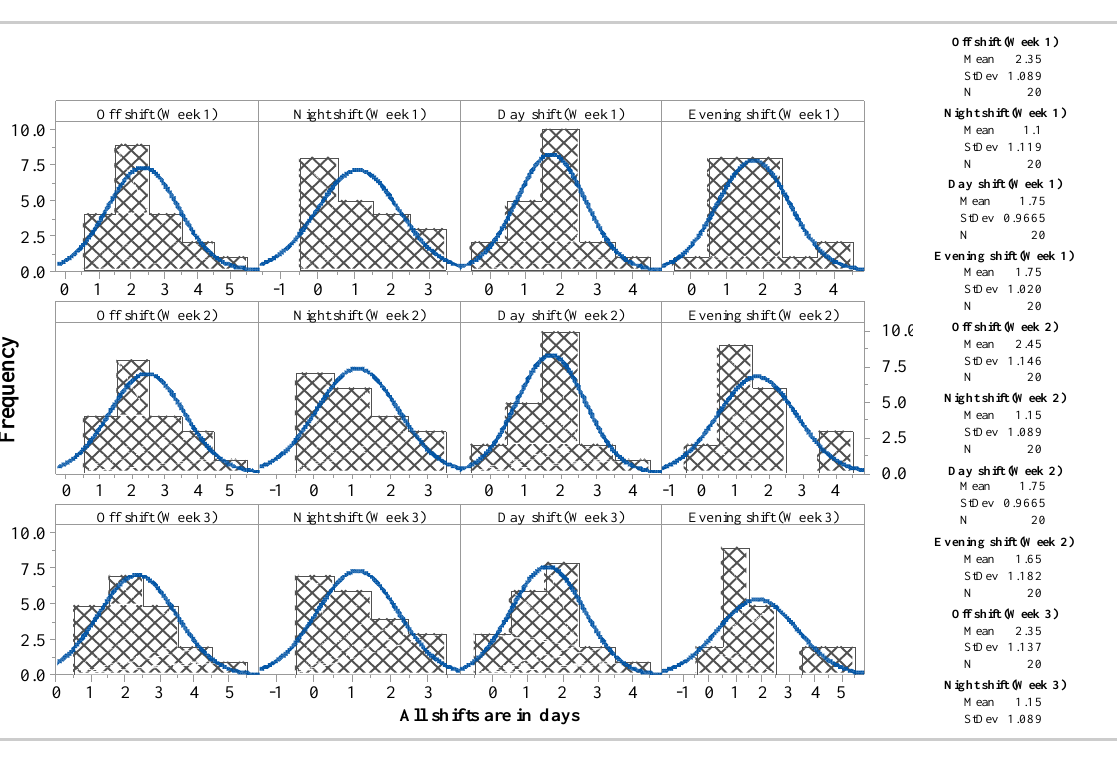
Figure 9. Normal Distribution for the Scheduled Shifts (week 1 to week